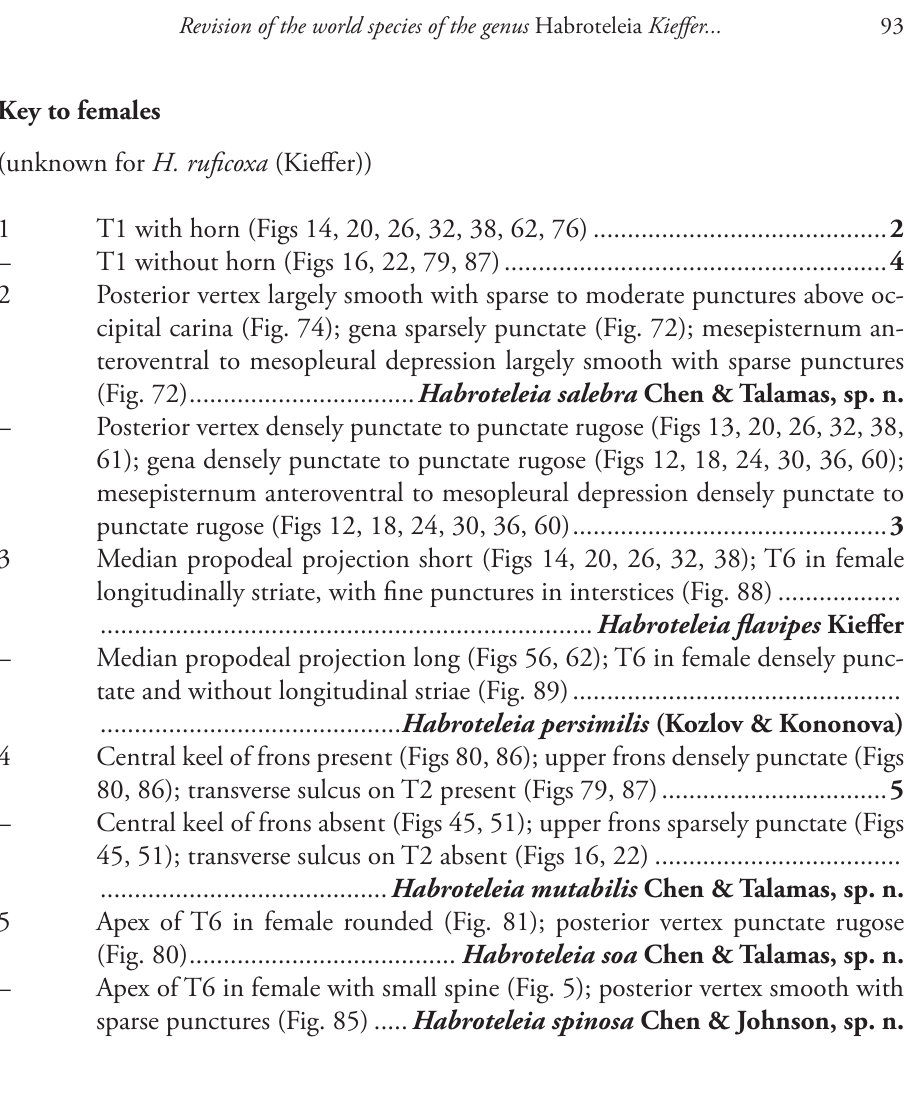
Key to males Apex of T8 with apical spine (Fig. 3) .......................................................... 2 Apex of T8 without apical spine (Fig. 4) ..................................................... 4 2 Occipital carina interrupted medially (Fig. 74); posterior vertex largely smooth with sparse to moderate punctures above occipital carina (Fig. 74); gena sparsely punctate (Fig. 72) ........................ Habroteleia salebra Chen & Talamas, sp. n. – Occipital carina complete (Figs 14, 20, 26, 32, 38, 80); posterior vertex densely punctate or punctate rugose (Figs 14, 20, 26, 32, 38, 79); gena dense- ly punctate or punctate rugose (Figs 12, 24, 30, 36, 78) .............................